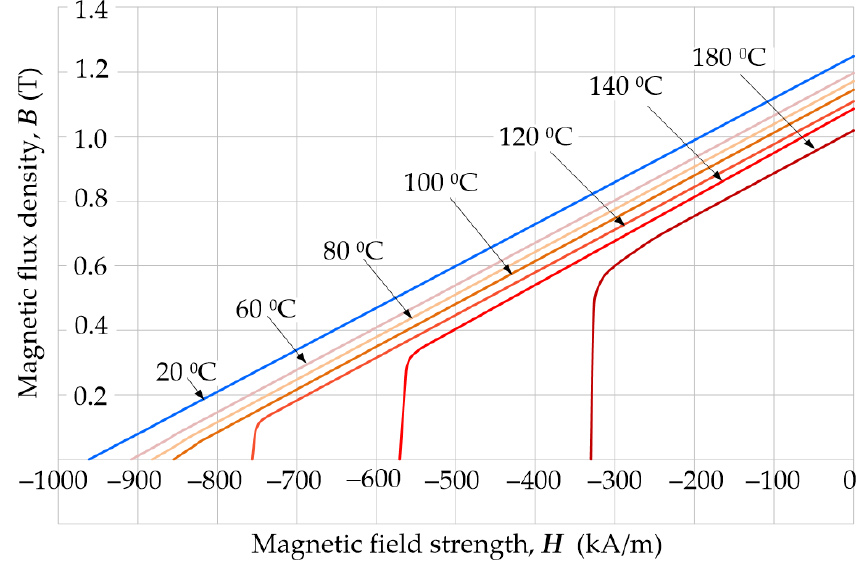
Figure 1. Family of demagnetization characteristics B ( H , ) of magnetically hard N38SH material.